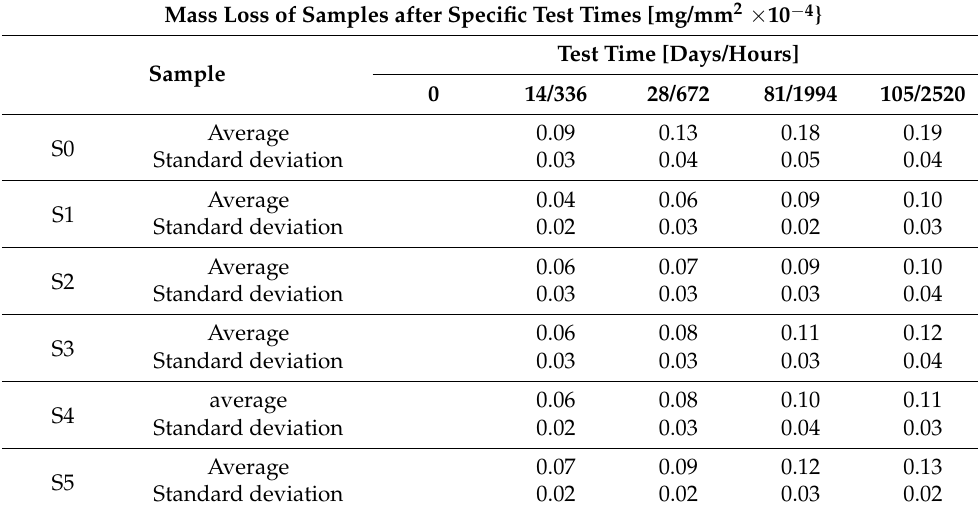
Table 4. Mass losses for particular samples examined in sea water